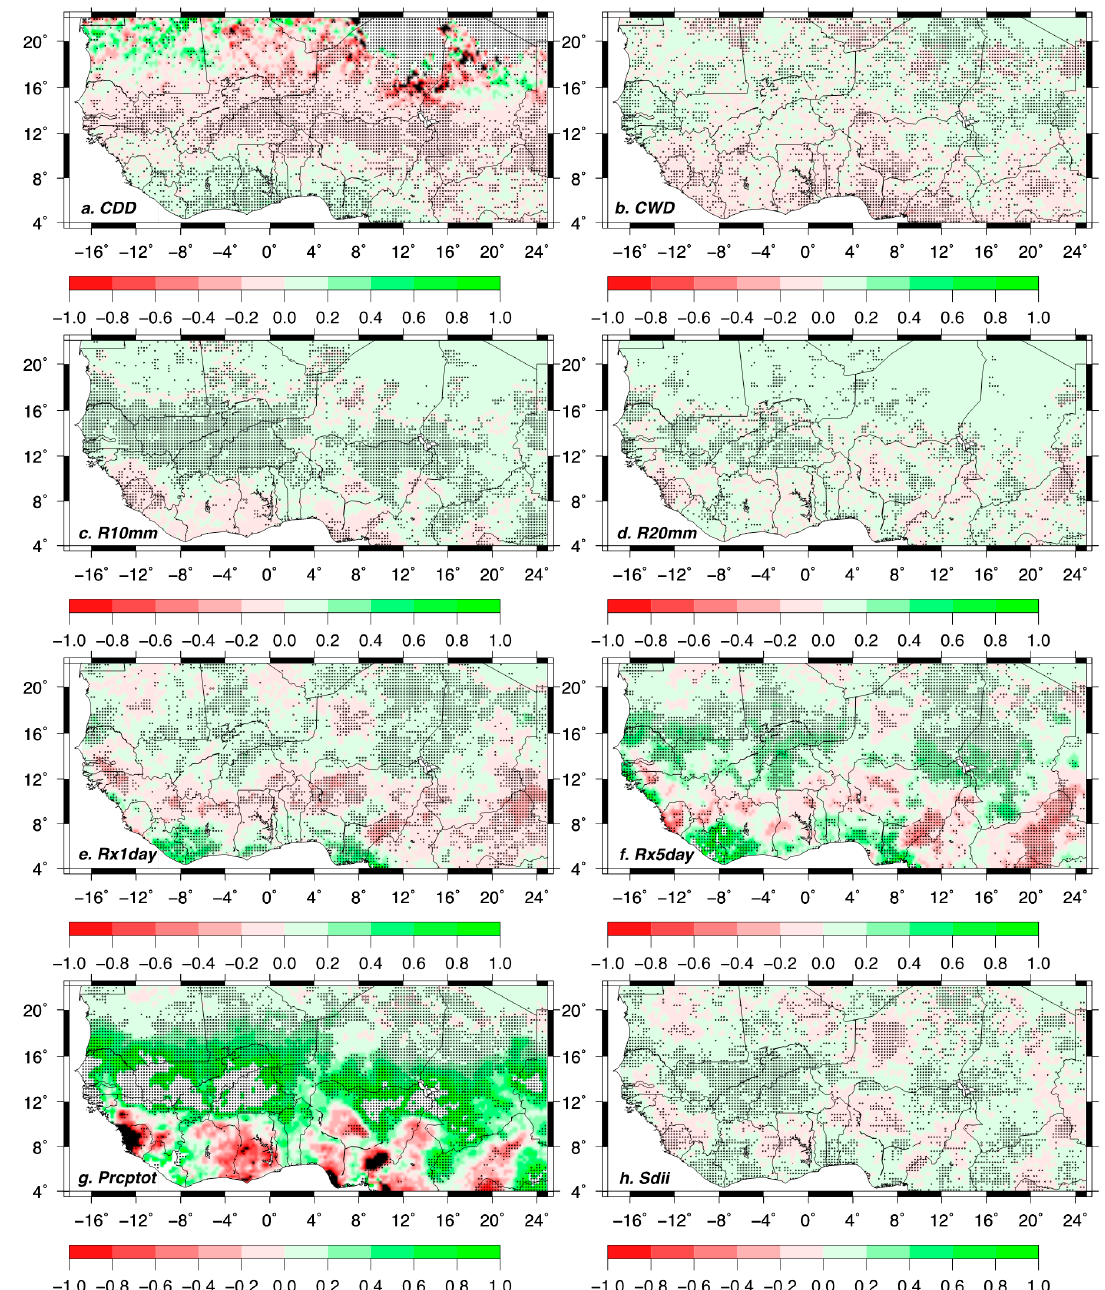
Figure 2. Seasonal (JJAS) Trends of extreme precipitation indices in West Africa from 1982 to 2016. Stripping points represent significant trend, black shaded indicates values lower than − 1 and white shaded, values greater than 1. ( a ) CDD, ( b ) CWD, ( c ) R10mm, ( d ) R20mm, ( e ) Rx1day, ( f ) Rx5day, ( g ) Prcptot and ( h ) Sdii.